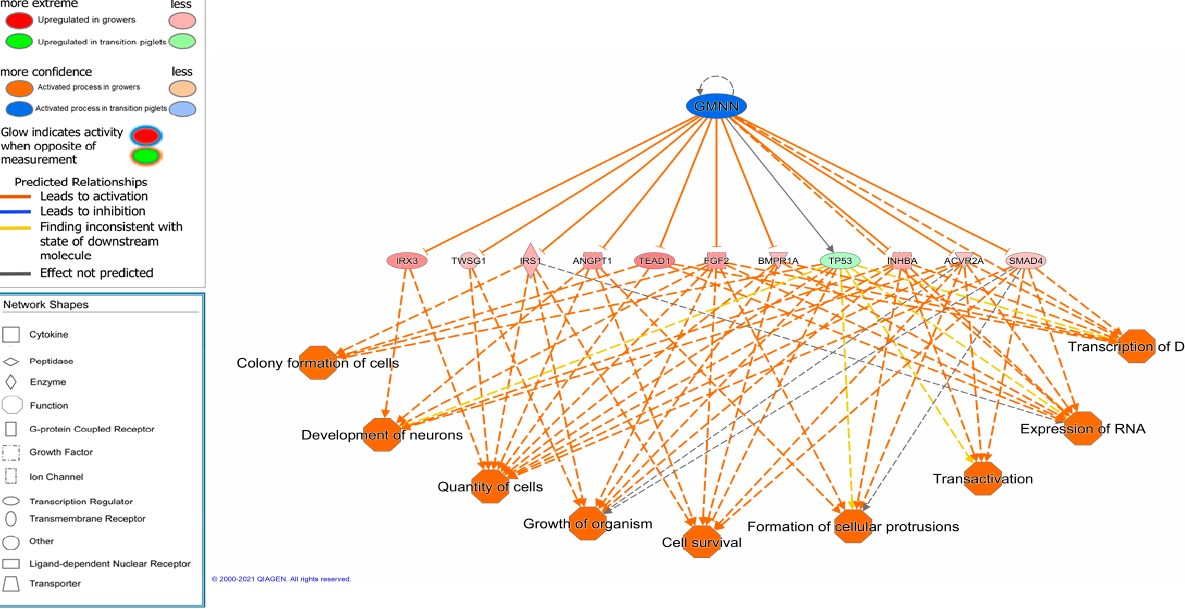
Figure 5. Regulator effects network predicted as activated in transition piglets, controlled by GMNN regulator .